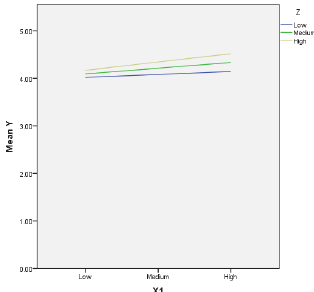
Fig. 2. Regression with Conditional Value Variable Work Passion Behavior (Z) for Job Satisfaction (X1)